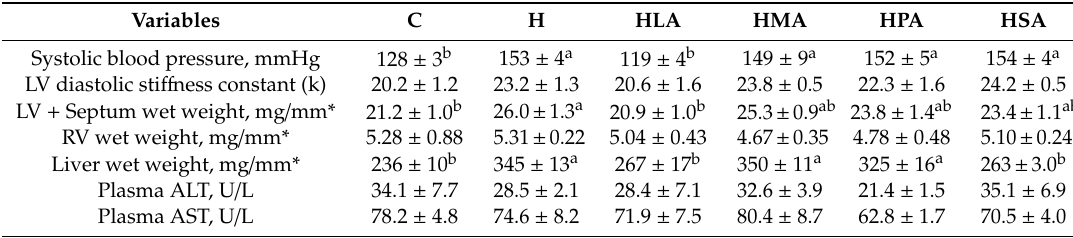
Table 3. Cardiovascular and liver parameters in rats treated with fatty acids.